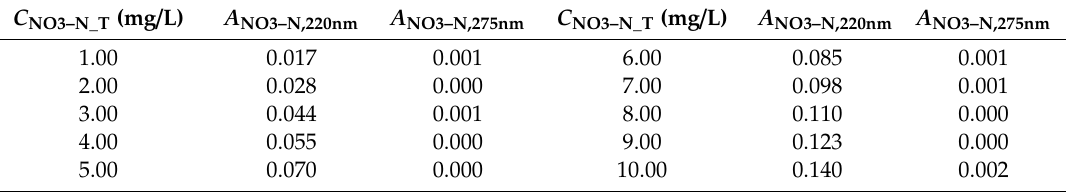
Table 7. Absorbance of di ff erent concentrations of NO 3 –N standard solution at 220 nm and 275nm.